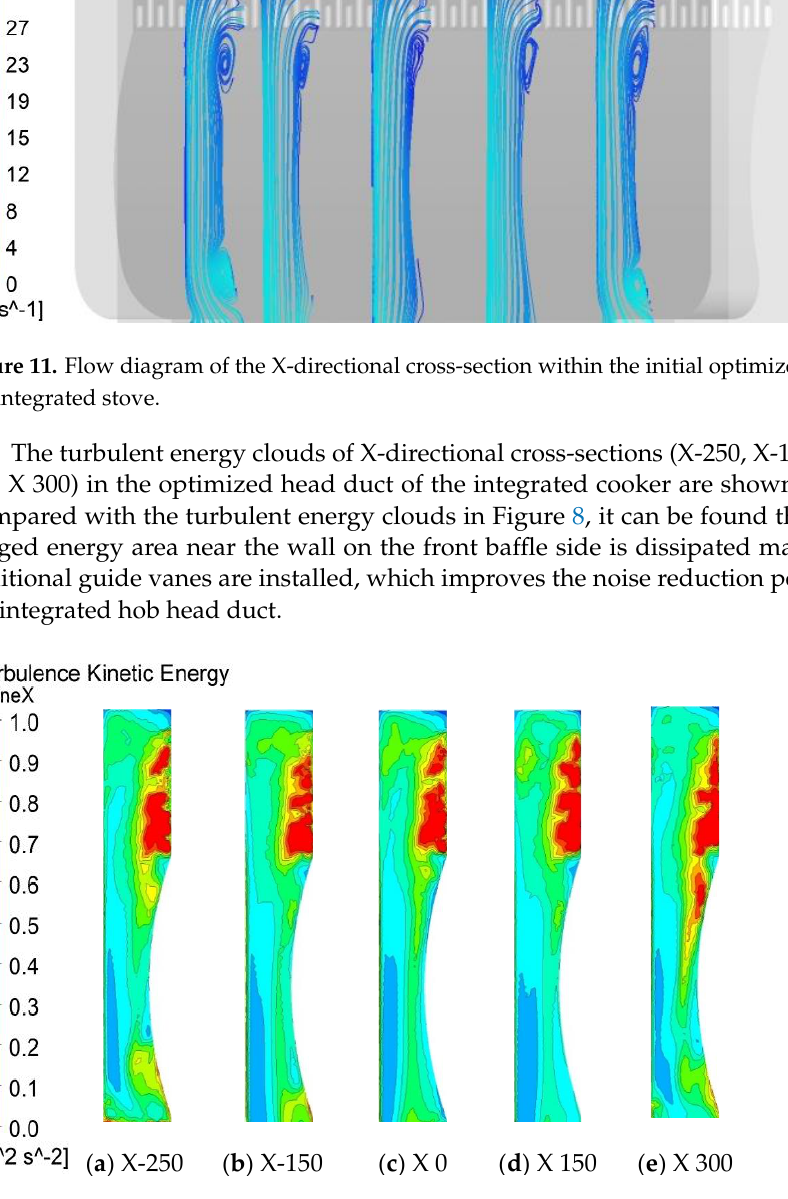
Figure 12. Turbulent energy cloud of X-directional cross-section in the preliminary optimized head duct of the integrated stove in head air duct of integrated stove.